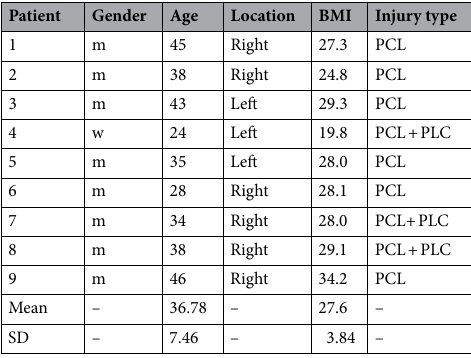
Table 1. Demographic data of the analysed patients. PCL Posterior cruciate ligament, PLC Posterolateral corner.